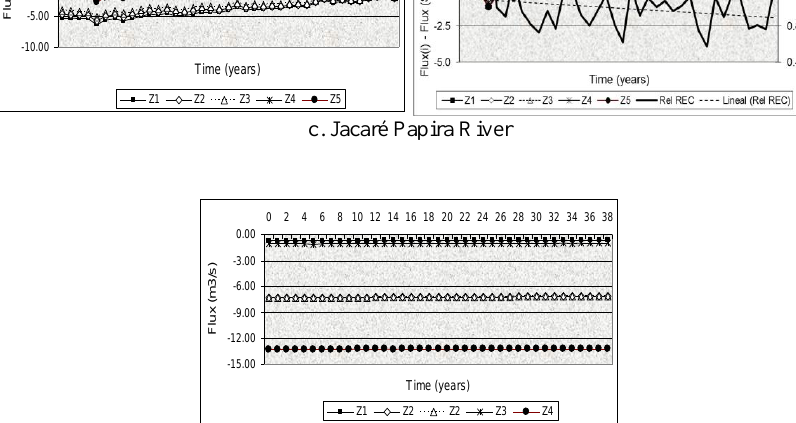
Fig. 10. Left: stream/aquifer flux (m 3 s − 1 ) versus time for selected streams for all conductivity zonations. Right: ratio of transient recharge to steady state recharge (solid line – dimensionless) and change of stream/aquifer flux with respect to steady state condition (m 3 s − 1 ) for all conductivity zonations (the latter is not included for the Paran´a River because the magnitude of the change was negligible, i.e. less that 0,1 m 3 s − 1 , for all